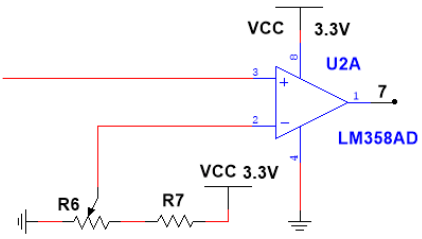
Figure 6. Voltage comparison circuit.